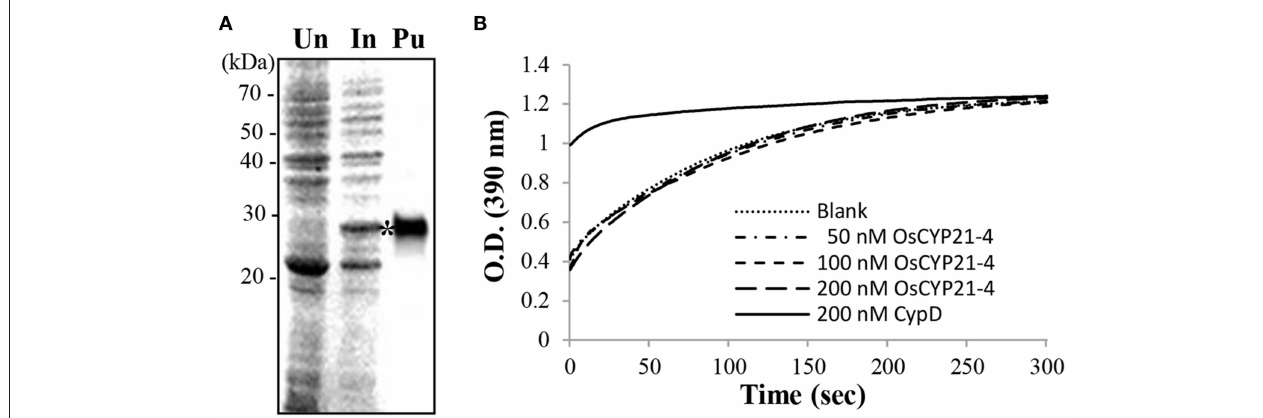
FIGURE 4 | Recombinant OsCYP21-4 lacks PPIase activity in vitro . (A) Recombinant OsCYP21-4 expression was induced with IPTG in E. coli and purified on nickel-NTA agarose columns. Samples were separated by 12% SDS-PAGE and stained with Coomassie blue. Un/In: Total protein un-induced/induced with isopropyl β -D-1-thiogalactopyranoside in E. coli; Pu: Purified OsCYP21-4 protein (star). (B) Traces showing isomerization of the Suc-AAPF-pNA substrate in the absence of OsCYP21-4 (Blank; …) and in the presence of 50nM (50nM OsCYP21-4;– - ), 100nM (100nM OsCTP21-4;– - ), and 200nM (200nM OsCTY21-4; _ _) recombinant OsCYP21-4 protein. CypD (200nM CypD; ) as a positive control. A representative recording from one of three independent experiments is